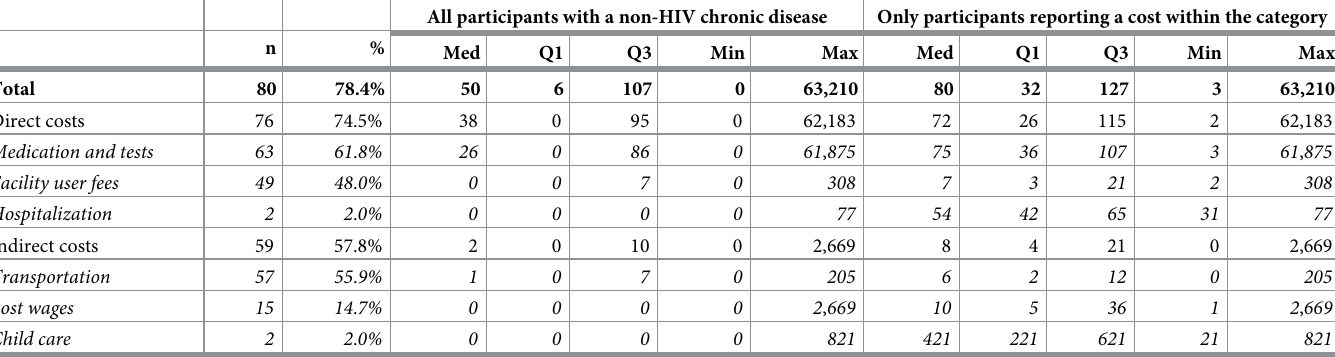
Table 4. Annual costs related to chronic disease care (N = 102) (2019